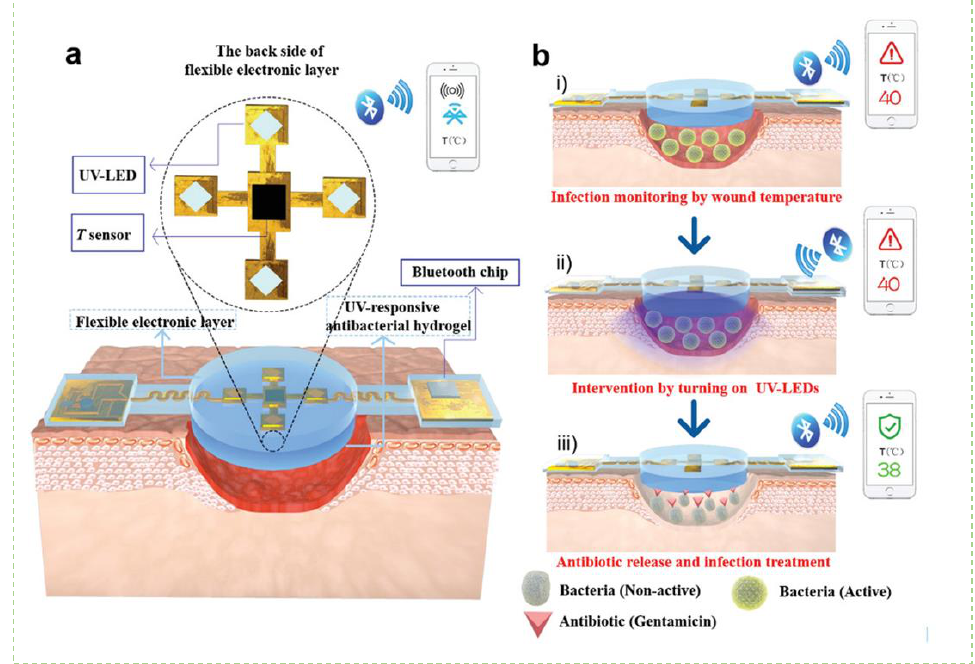
Figure 5. The design and the working of the smart device for wound dressings ( a ). The device consists of polydimethylsiloxane surrounded electronic layer and an antibacterial hydrogel to monitor the temperature and four UV LEDs that emit UV light to release the antibiotic from hydrogel; ( b ). Illustration of the working of the device during wound monitoring and treatment. (i). Infection is monitored by change in wound temperature; (ii). Any change is intervened by turning of UV